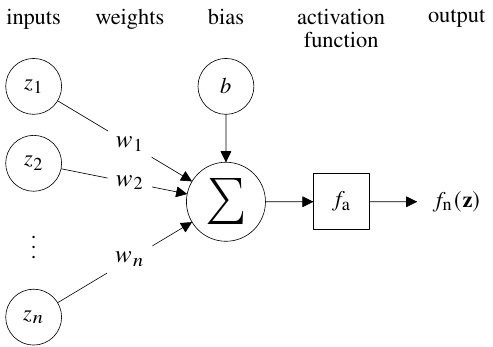
Figure 1. Graphical representation of the calculation procedure of a single